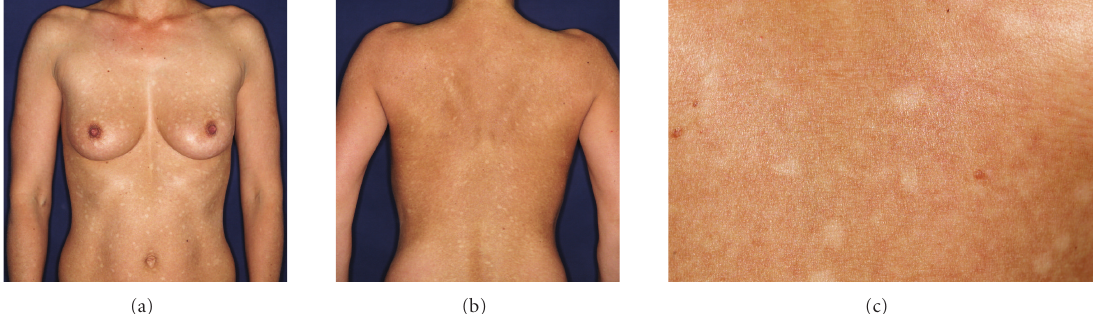
Figure 1: (a) Disseminated whitish macules on the front and the back of the trunk. (b) Nonscaly macules in detail on the back.